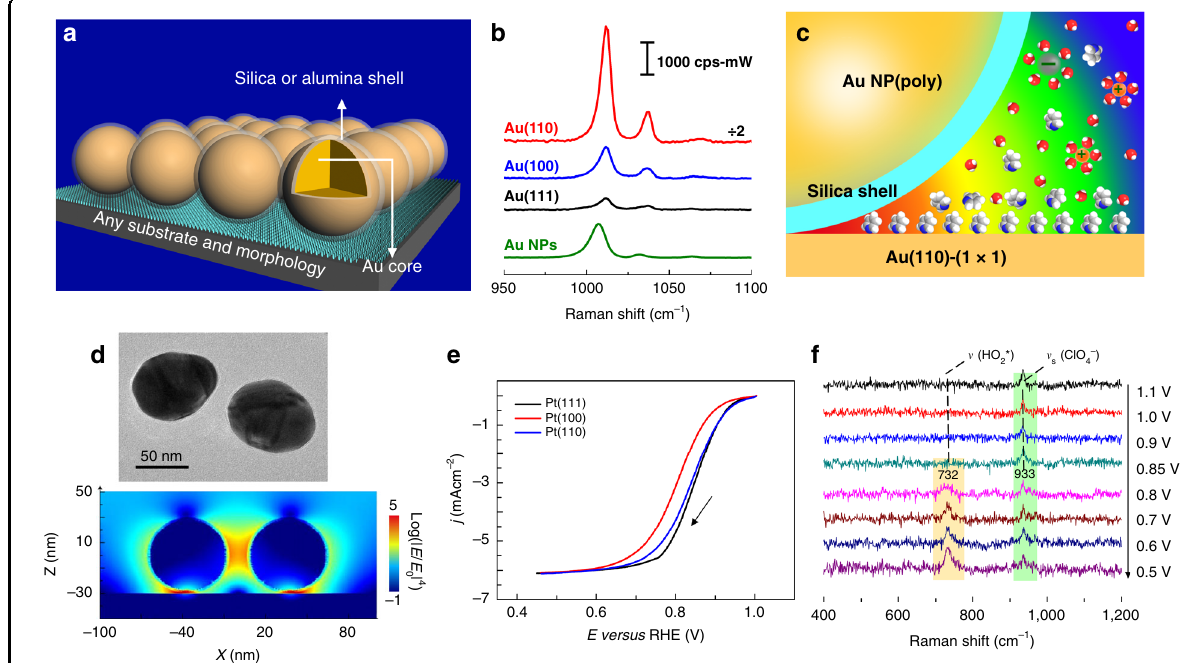
Fig. 7 SHINERS for surface detection. a SHINERS on a substrate 31 . b SHINERS spectra of pyridine adsorbed on Au(111), Au(100), and Au(110) at 0.00 V. Solution: 10 mM pyridine + 0.1 M NaClO 4 . SERS spectra of pyridine on bare 55 nm gold NPs at different potentials. c Schematic diagrams of the SHINERS experiments. The EM fi eld strength is represented by the following color code: red (strong) and blue (weak). 67 d TEM and simulated images. 3D-FDTD simulations of four SHINs with a model of a 2 × 2 array on a Pt substrate. E and E 0 represent the localized electric fi eld and the incident electric fi eld, respectively. e Polarization curves of the ORR process at three Pt(hkl) RDEs in oxygen-saturated 0.1 M HClO 4 solutions; the rotation rate was 1600 r.p.m. and the scan rate was 50 mV s − 1 . j and E represent the current density and potential, respectively. f EC-SHINERS spectra of the ORR system at a Pt(111) electrode surface in a 0.1 M HClO 4 solution saturated with O